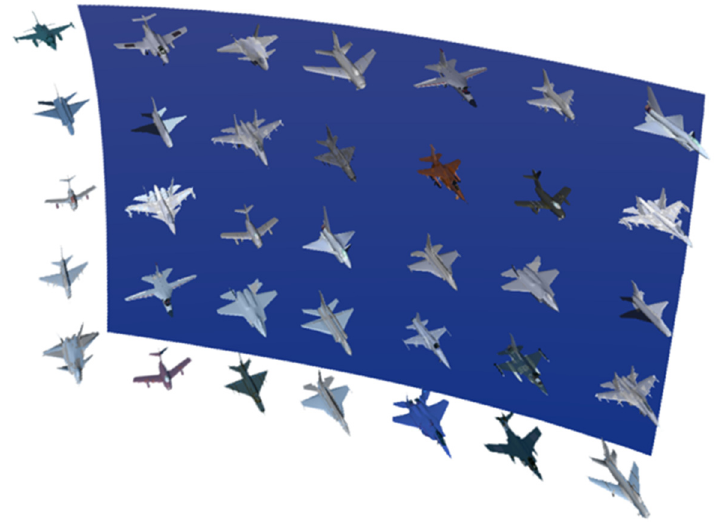
Figure 8. The information display layer in the accurate identification class information depth distance experiment.